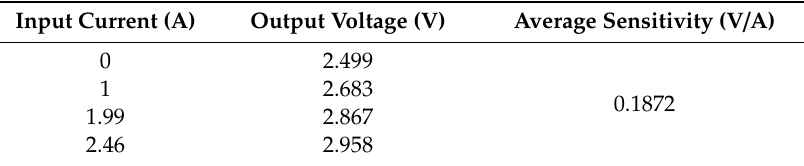
Table 2. Testing result of battery current sensor.